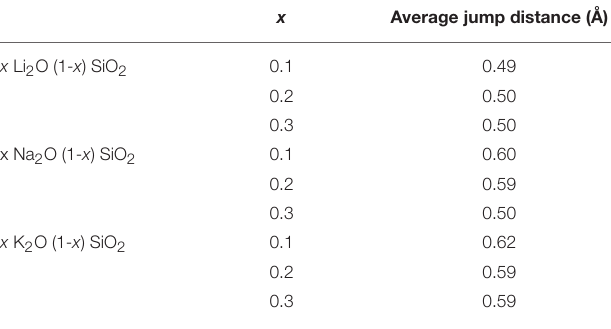
TABLE 3 | Average jump distance (in Å) for each composition obtained by peak fitting of the probability density function from Figure 2 . x Average jump distance (Å) x Li 2 O (1- x ) SiO 2